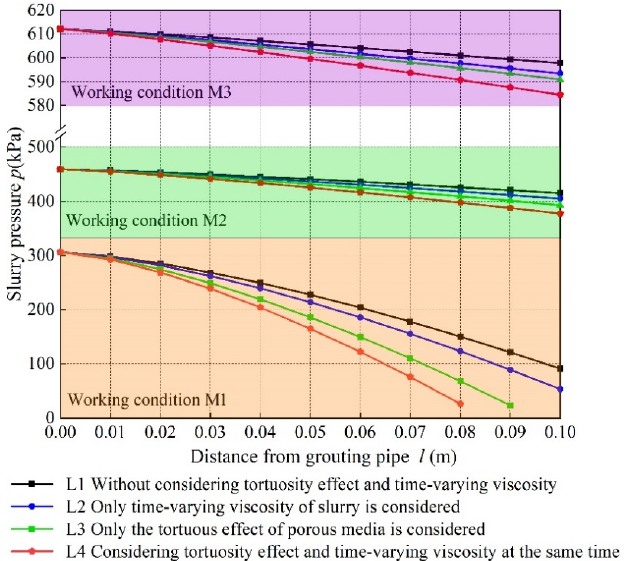
Figure 6. Attenuation law of the slurry